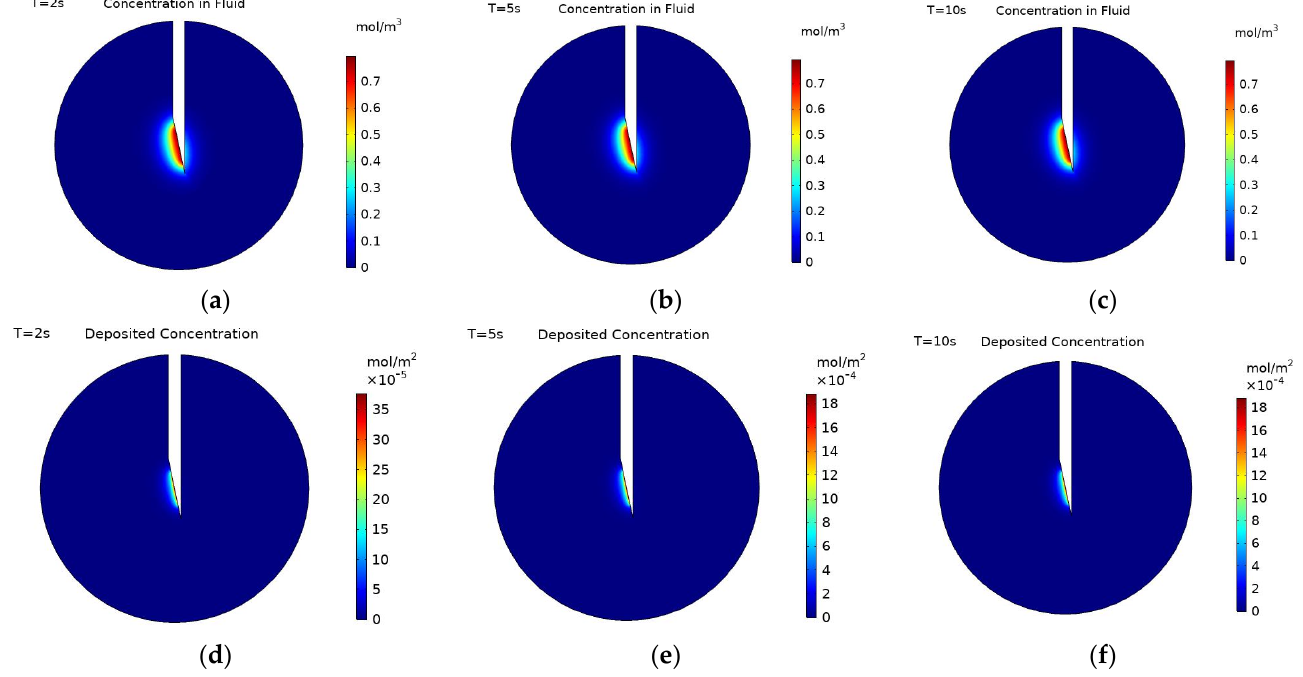
Figure 9. Concentration contours of uncharged nanoparticles within the fluid at; ( a ) 2 s, ( b ) 5 s, and ( c ) 10 s during injection, and concentration contours of uncharged particles deposited onto cell surfaces at; ( d ) 2 s ( e ) 5 s, and ( f ) 10 s during injection.